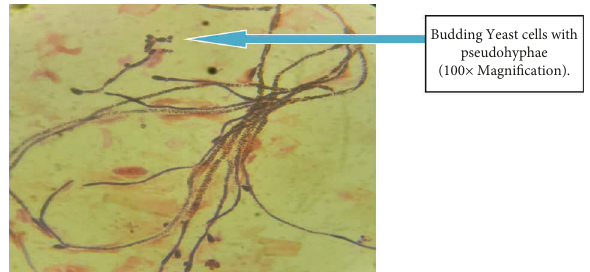
Figure 2: Budding yeast cells with pseudohyphae observed in Gram